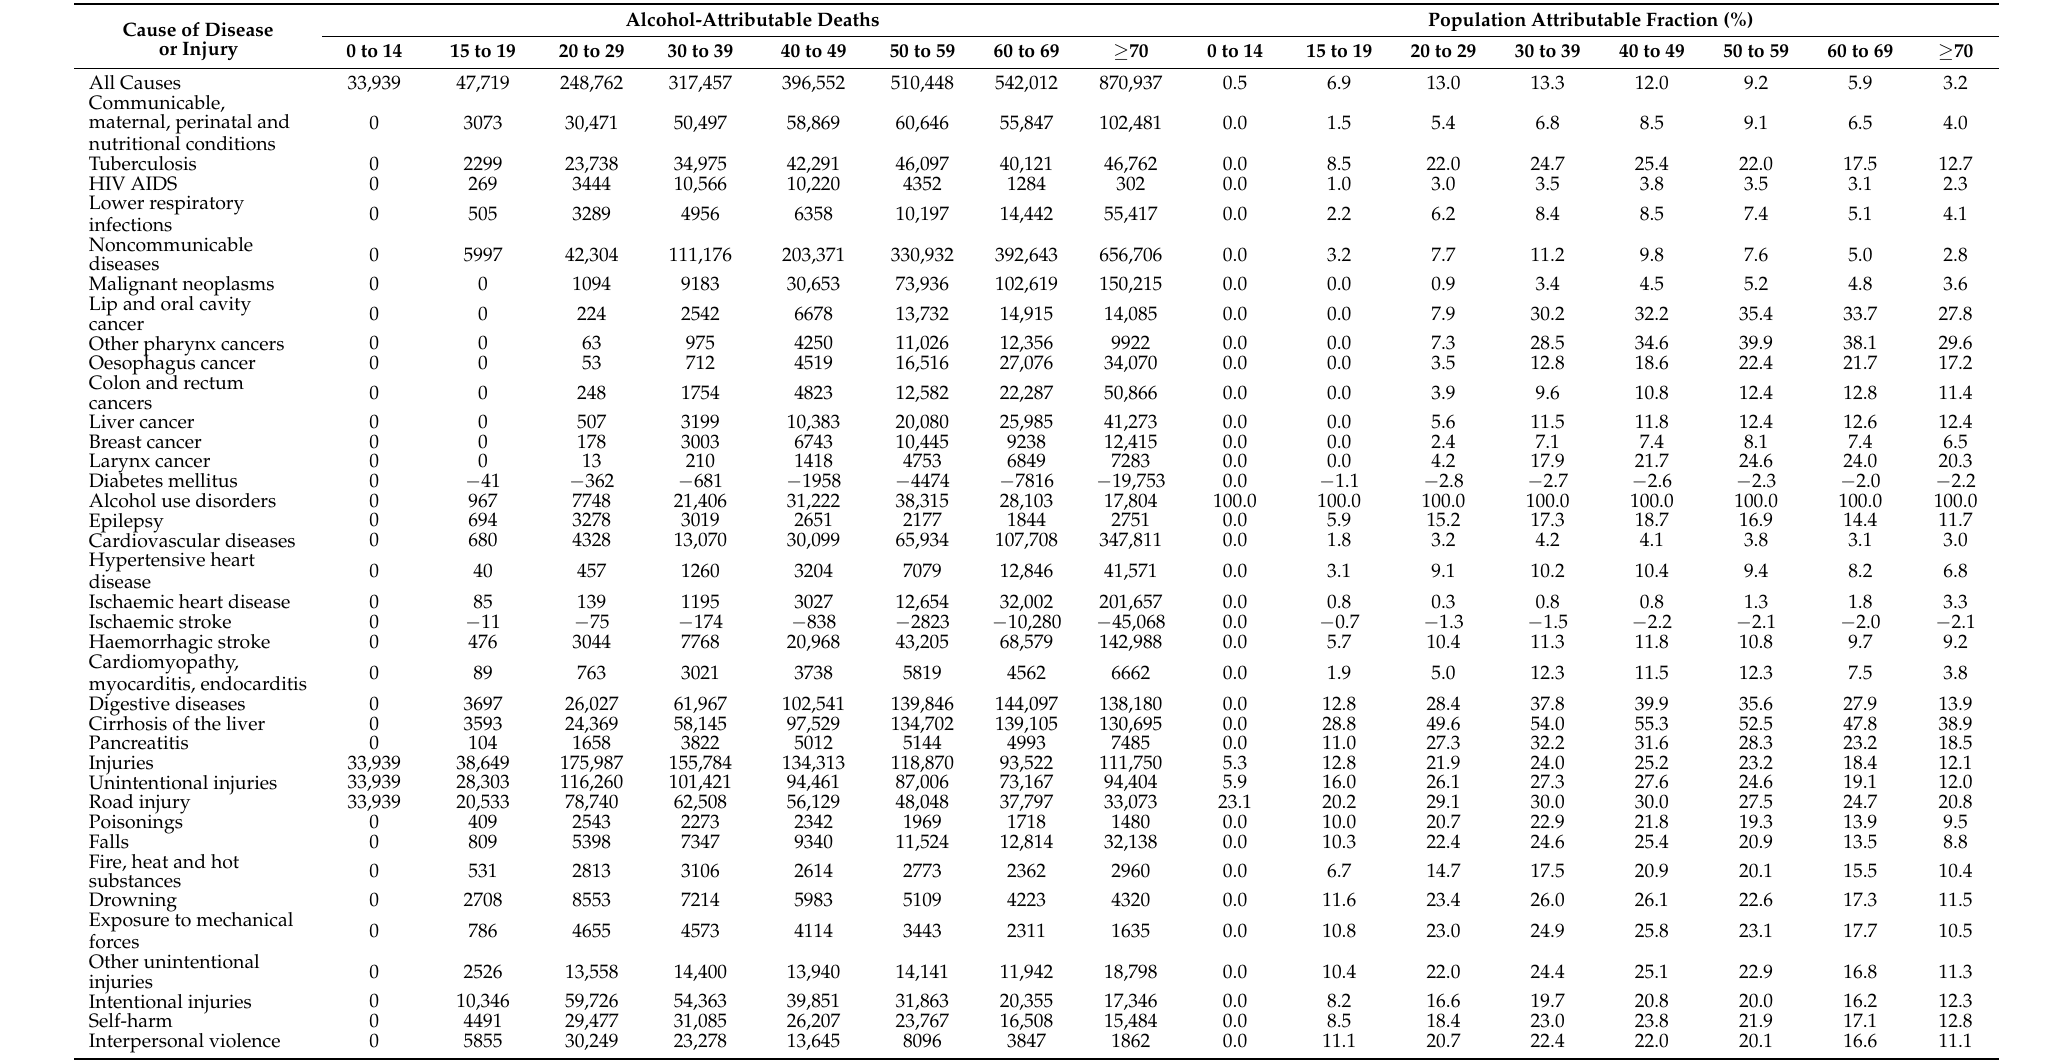
Table 1. Alcohol-attributable deaths globally in 2016, by cause and